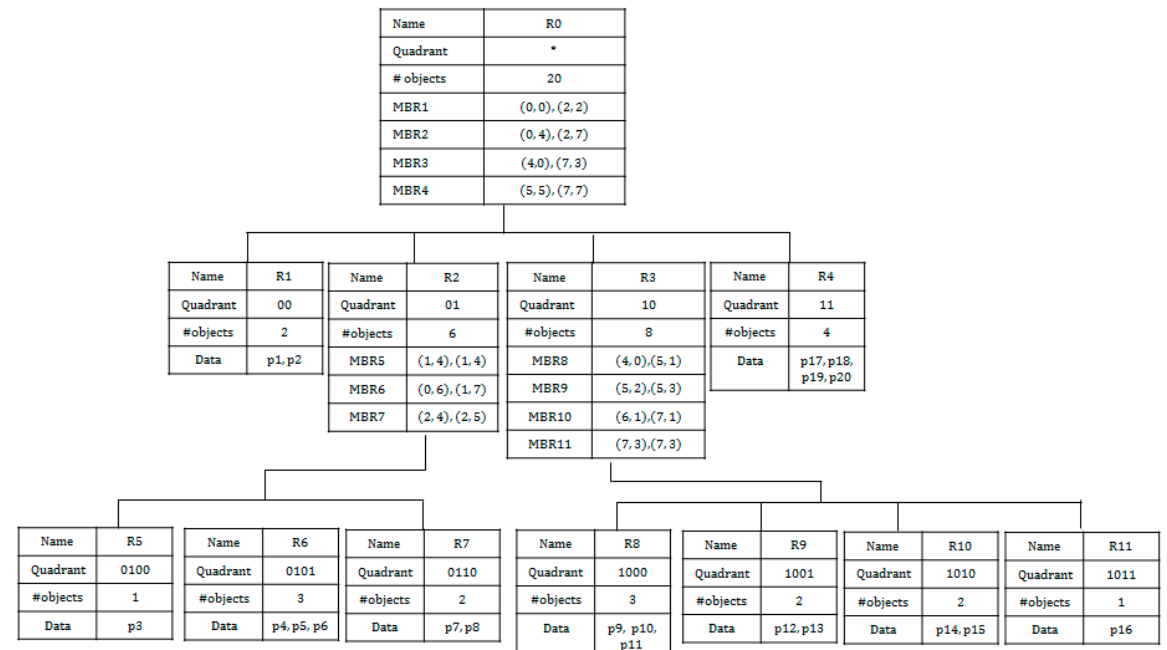
Figure 4. An example of a QbMBR tree.